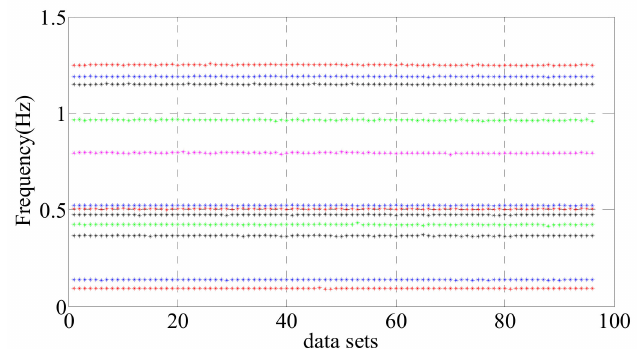
Figure 6. Ninety-sixsets of modal frequencies identified by Natural Excitation Technique / Eigensystem Realization Algorithm